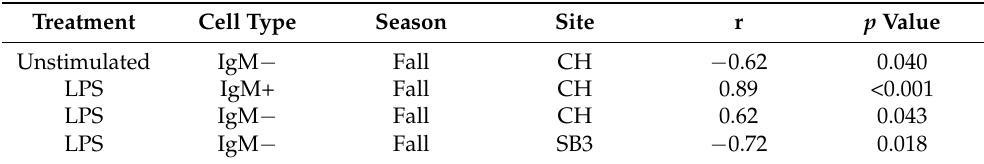
Table 4. Correlations between splenic macrophage aggregates and lymphocyte mitogenesis for smallmouth bass ( Micropterus dolomieu ) collected from the Cheat River (CH) and South Branch Moorefield site (SB3). No significant correlations were observed at the South Branch Petersburg site